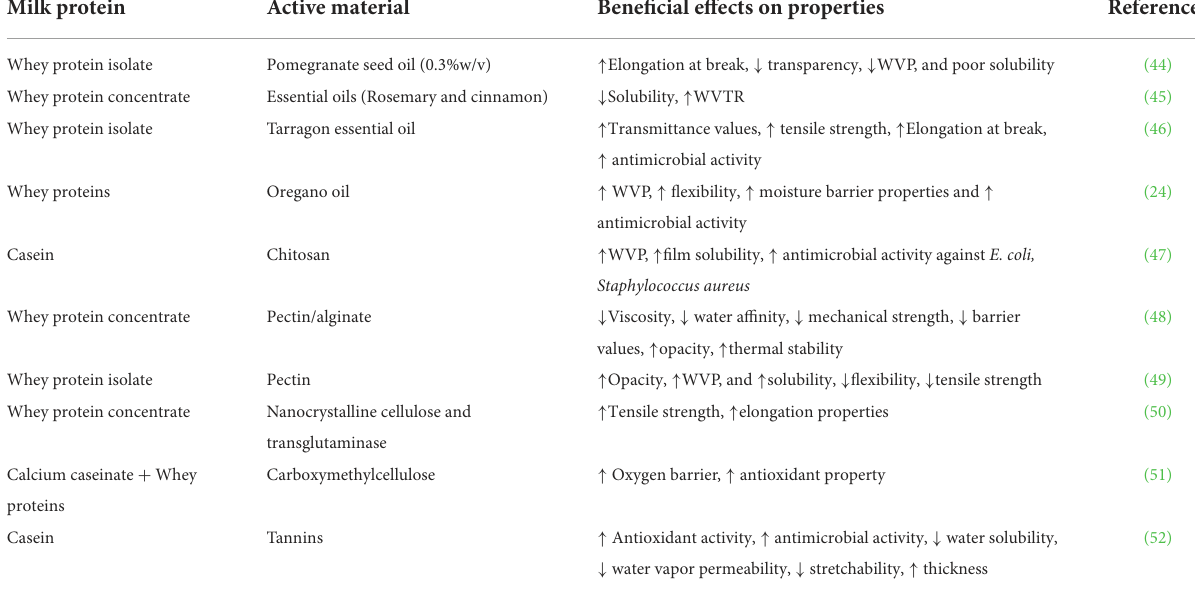
TABLE 1 Mechanical, barrier, and functional properties of milk protein-based active packaging materials. Milk protein Active